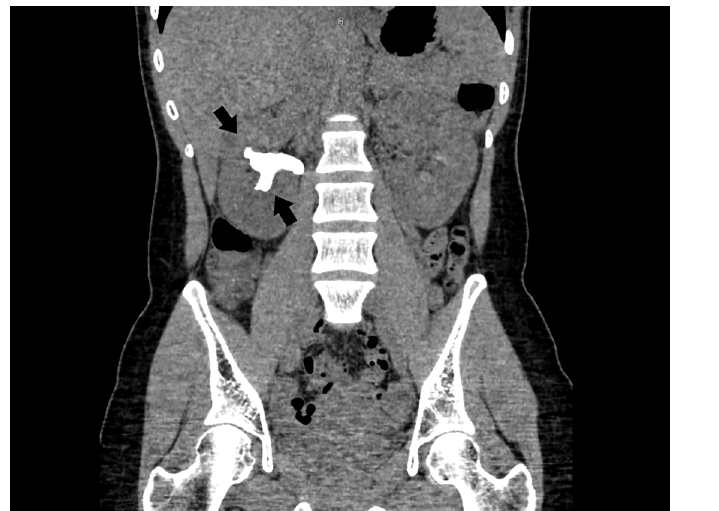
Image 2. Coronal computed tomography image showing calculus filling entirety of right renal pelvis